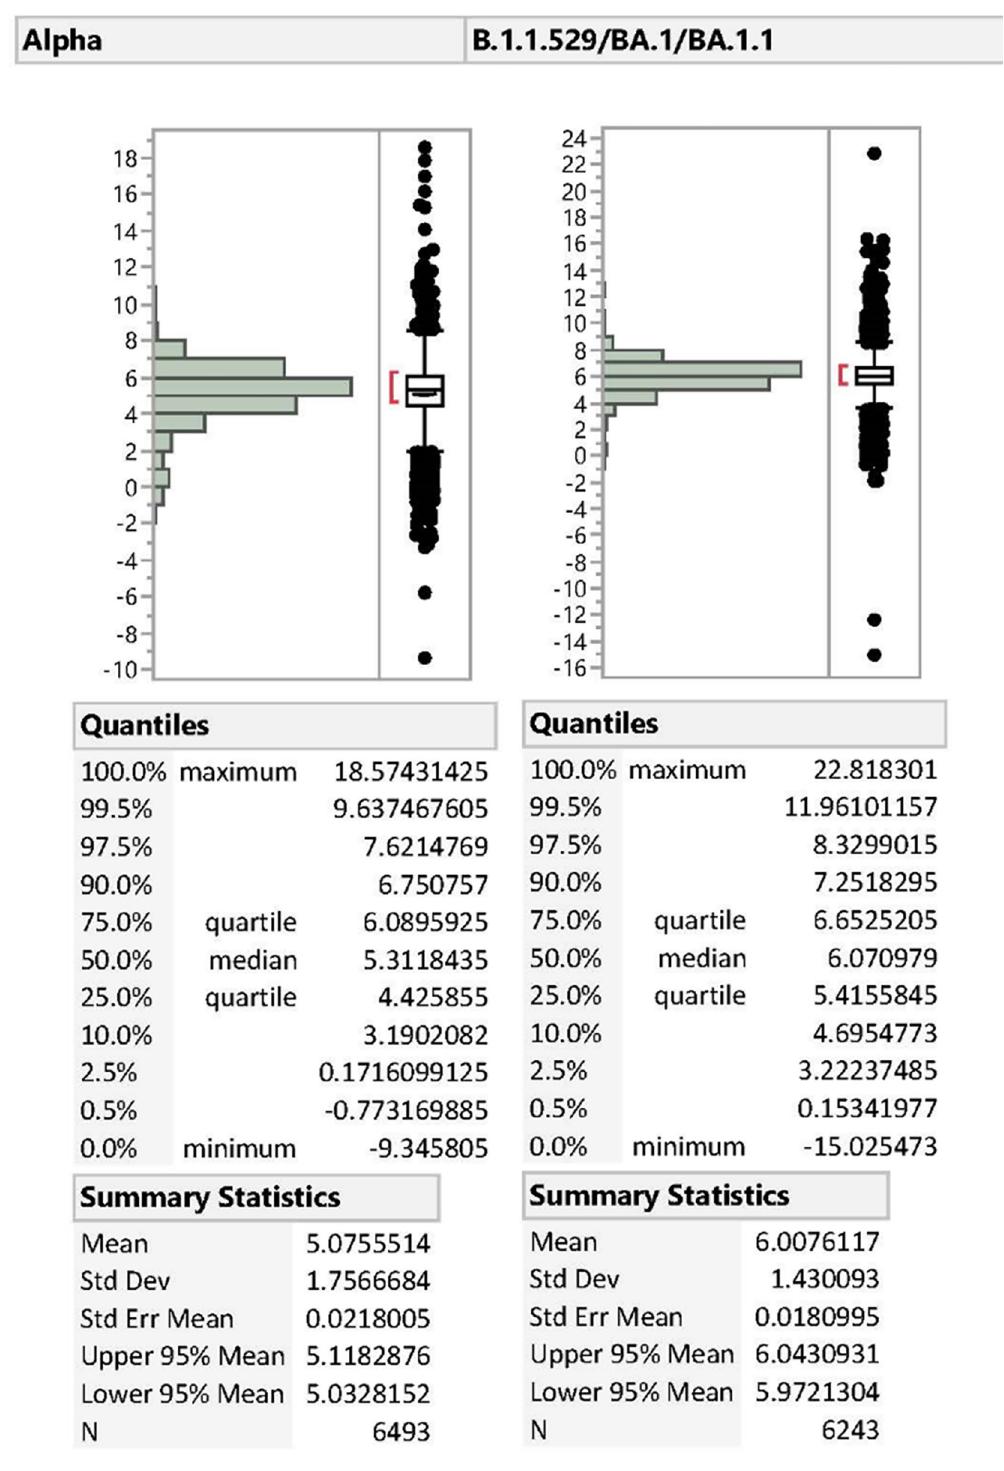
Fig 2. Distribution of Ct value differences between the S-gene and the average of N and ORF1ab-genes in Alpha and Omicron B.1.1.529/BA.1/BA.1.1 variants.